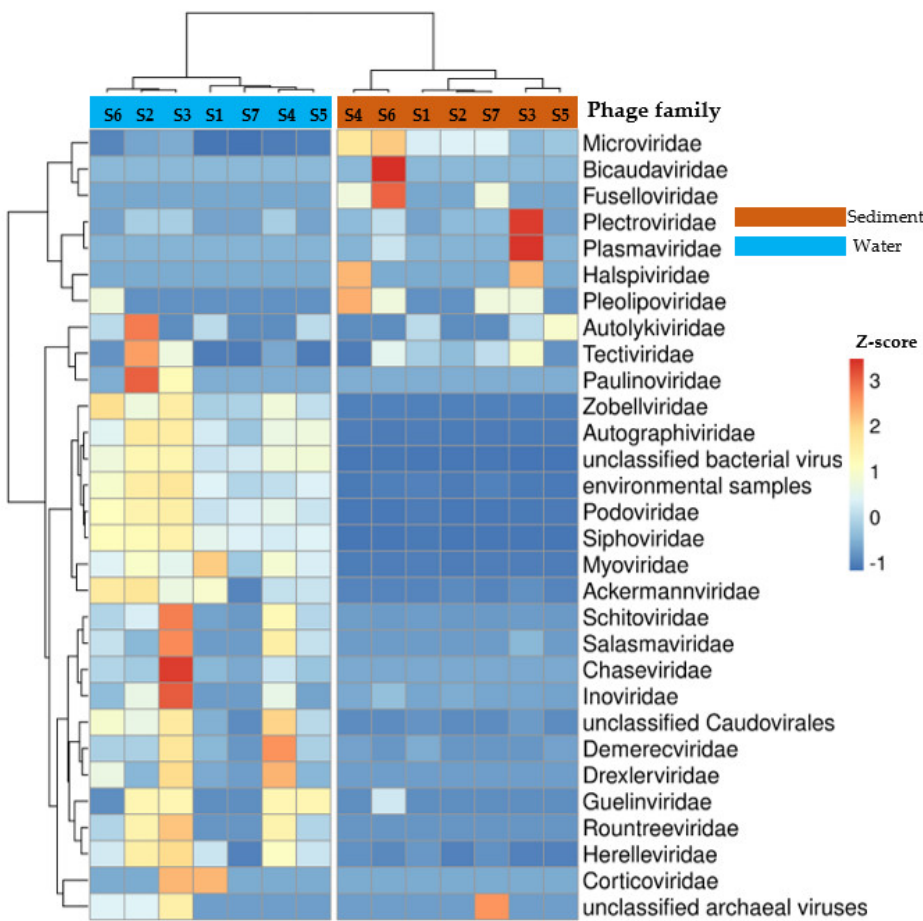
Figure 2. Hierarchical heatmap representing the relative abundance of the main phage families in the sediment and water samples of the seven stations (S1–S7). Number of contigs were normalized up to the smallest given contigs count for every samples. The relative abundance is represented by Z-score (based on the mean and standard-deviation (SD) of Z-scores for each family group in all samples). The stations and phage families were clus-tered using the Bray-Curtis distance, which is represented by a dendrogram on the top and right side of the graph. Z-scores are scaled by the relative abundance of phage families.